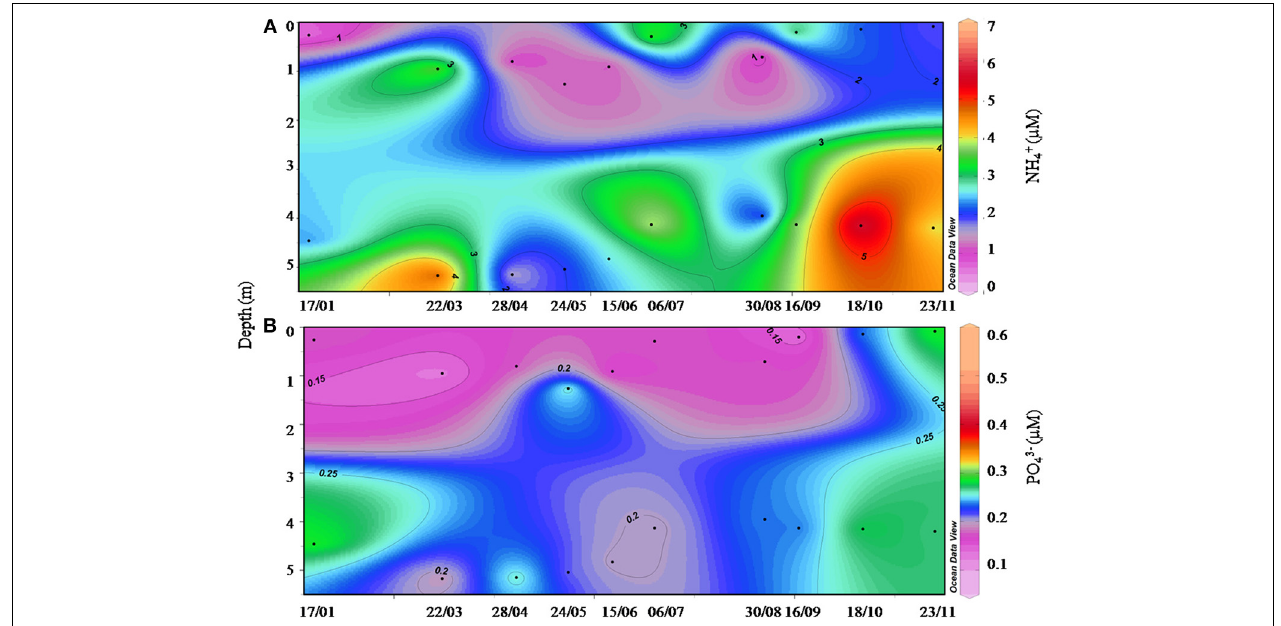
FIGURE 7 | Vertical distribution of (A) ammonium and (B) phosphates concentrations measured by the GIPREB at surface and bottom layers at the hydrological station in the Vaïne lagoon in 2011.